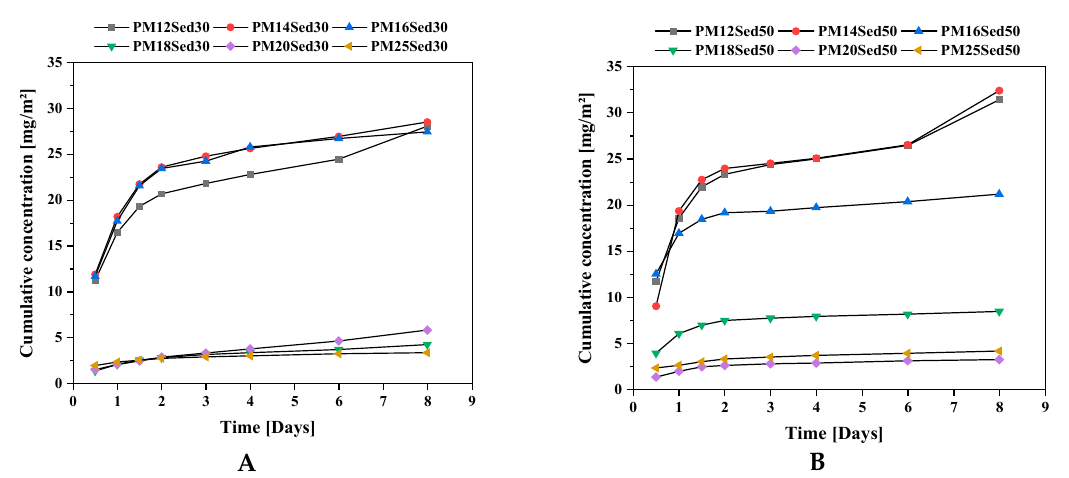
Figure 12. Evolution of the cumulative concentration of Copper in leachates from monolithic polymer mortars containing 30% ( A ) and 50% ( B ) of sediments in their matrices.